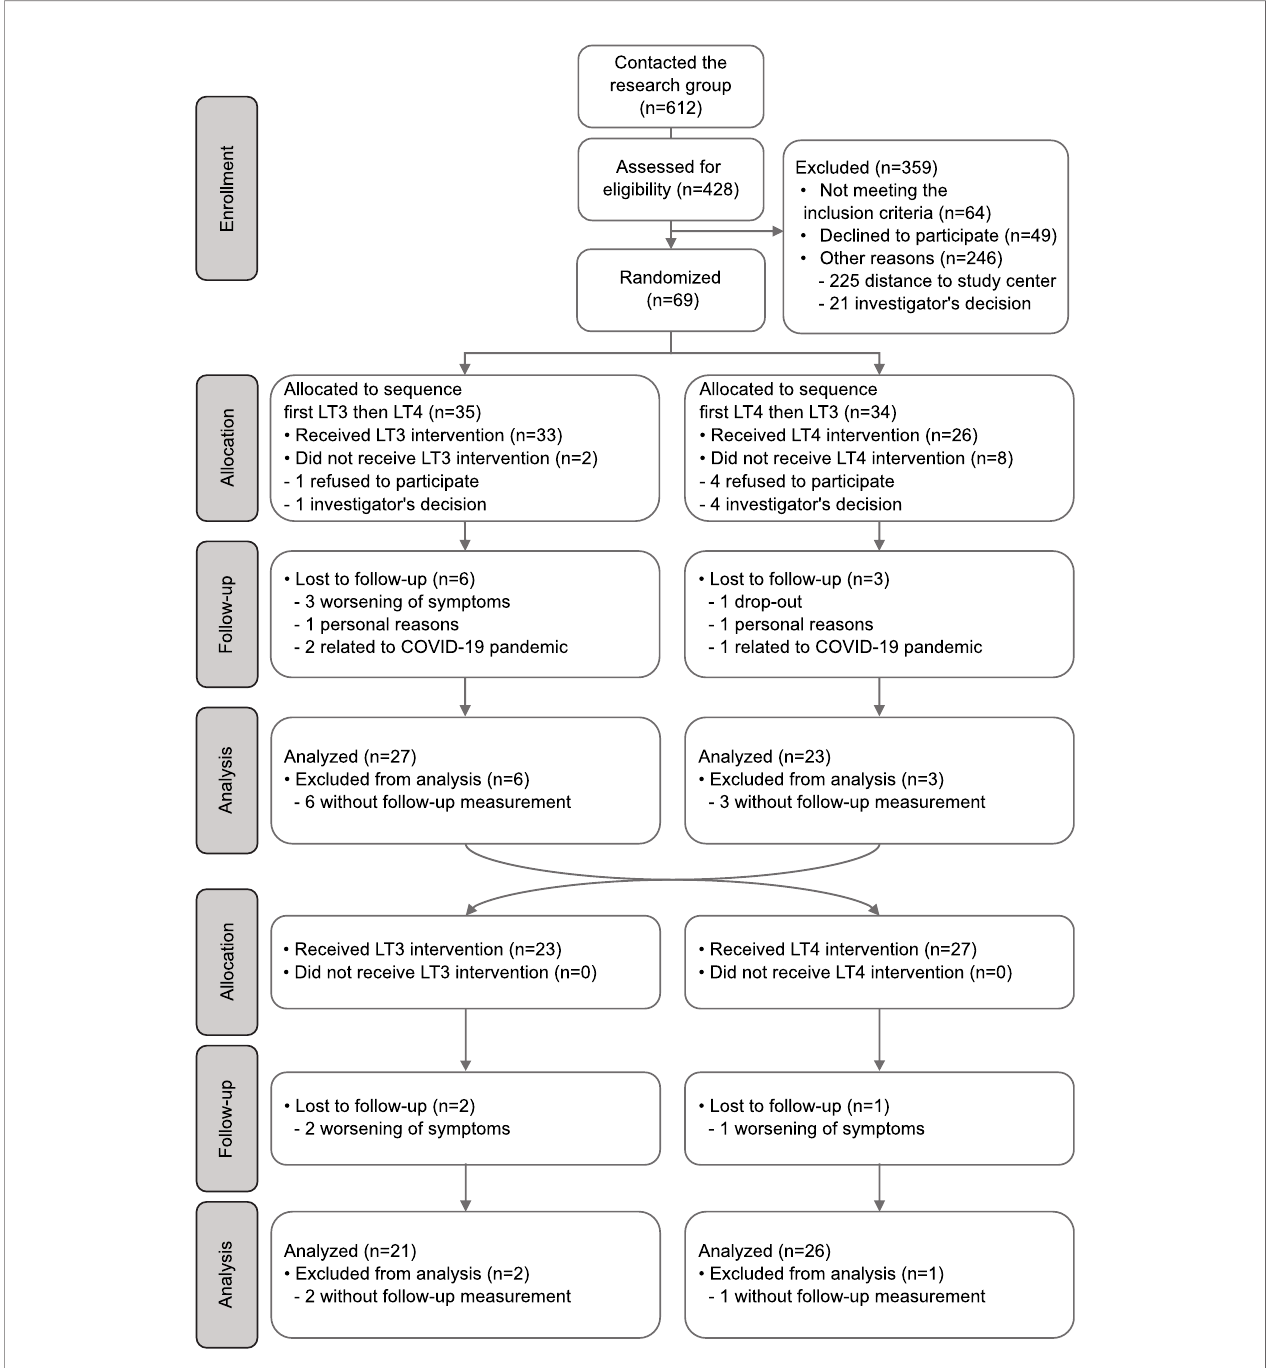
FIGURE 1 | Flow chart describing recruitment, randomization and analysis of patients in the